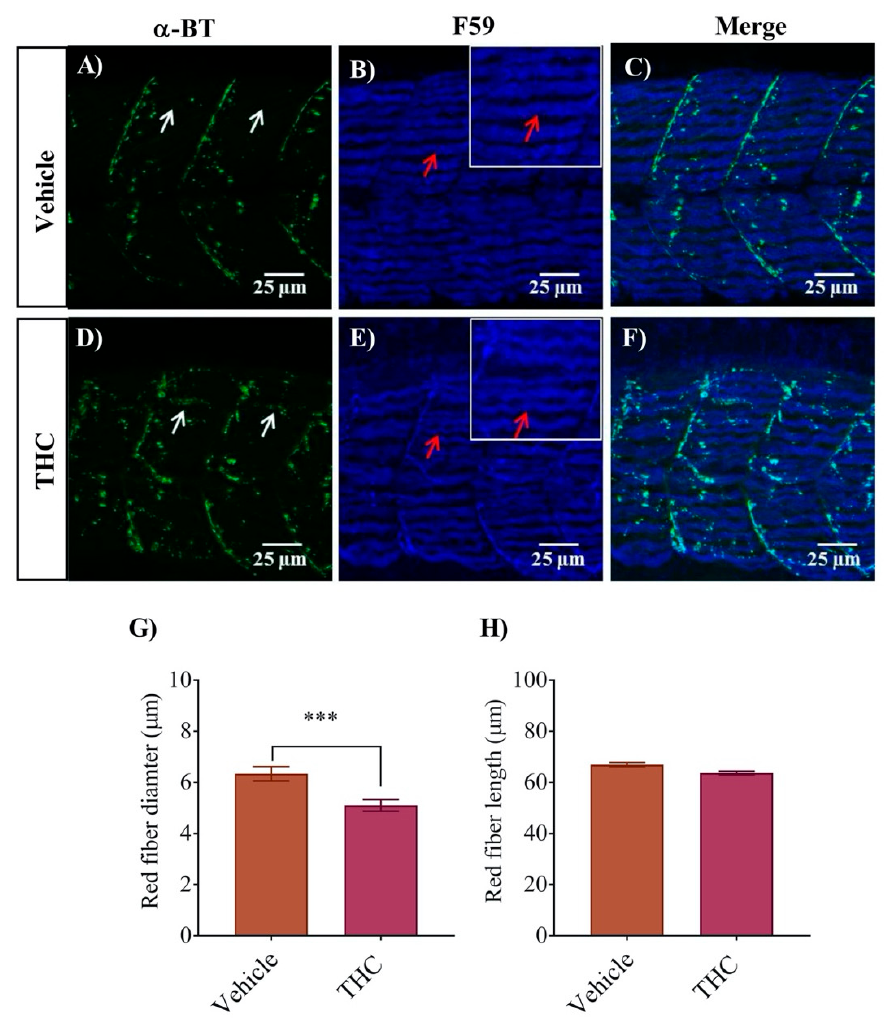
Figure 3. Co-labeling of red muscle fibers and nAChRs using anti-F59 and Alexa 488 conjugated α -bungarotoxin respectively. ( A ) α -Bungarotoxin labelled nAChRs associated with red muscle fibers in vehicle-treated embryos. ( B ) Anti-F-59 labelled muscle fibers. Red arrows point to the edge of a muscle fiber. Inset shows muscle fibers at higher magnification to better determine the size of the fiber. ( C ) Merged image showing the co-labeled red muscle fiber and nAChR in vehicle-treated animals. ( D ) α -bungarotoxin labelled nAChRs associated with red muscle fibers in THC-treated (6 mg / L) embryos. White arrow shows the cluster of nAChRs. ( E ) Anti-F59 labelled muscle fibers. Red arrows point to the edge of a muscle fiber. Inset shows muscle fibers at higher magnification to better determine the size of the fiber. ( F ) Merged image showing the co-labeled red muscle fiber and nAChR in THC-treated animals. ( G ) Bar graph showing the diameter of red fibers for vehicle and THC treated embryos and ( H ) Measurement of red fiber length. *** significantly di ff erent from vehicle control, p < 0.001.